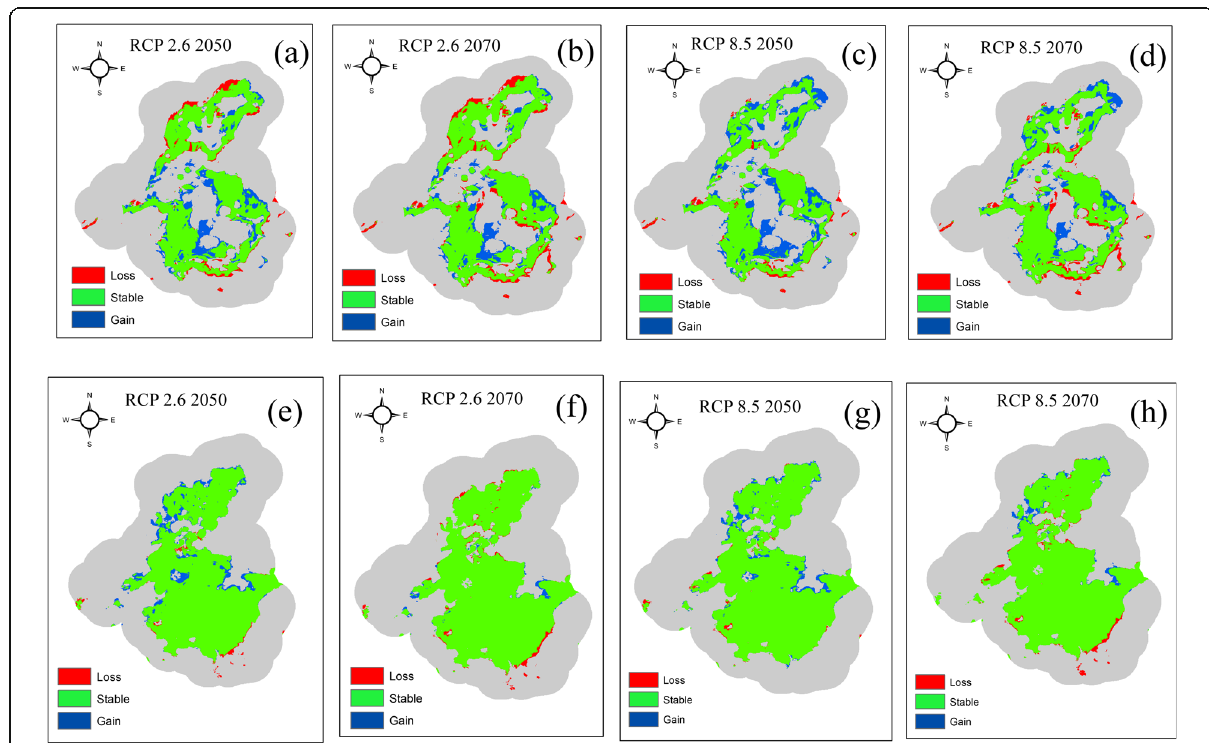
Fig. 7 Predicted change in the distribution of jungle cat and Asiatic wildcat under RCP 2.6 and RCP 8.5 scenarios: portions a – d represent the predicted gain and loss for jungle cat, and portions e – h represent the gain and loss in the distribution of Asiatic wildcat for the timelines (the 2050s and